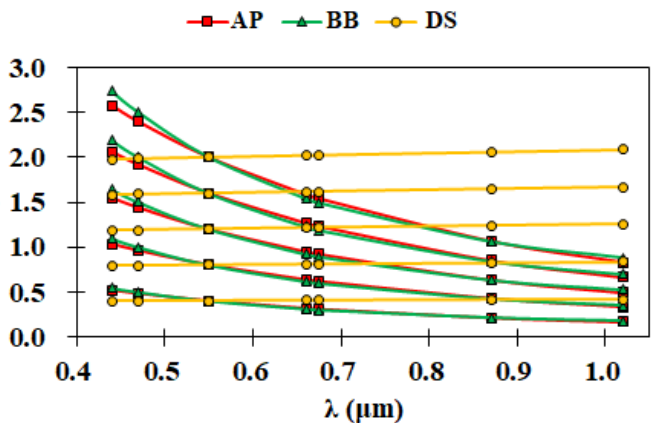
Figure 2. The simulated spectral aerosol optical depths (AODs) at 0.44, 0.47, 0.55, 0.66, 0.675, 0.87 and 1.02 µ m for DS (yellow), BB (green) and AP (red) aerosols under AOD (0.55 µ m) values of 0.4, 0.8, 1.2, 1.6 and 2.0 from the 6S (Second Simulation of a Satellite Signal in the Solar Spectrum) model with the experimental dataset.